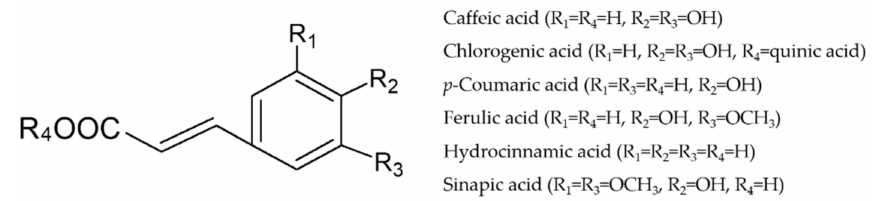
Figure 1. Chemical structure of caffeic acid and related hydroxycinnamic